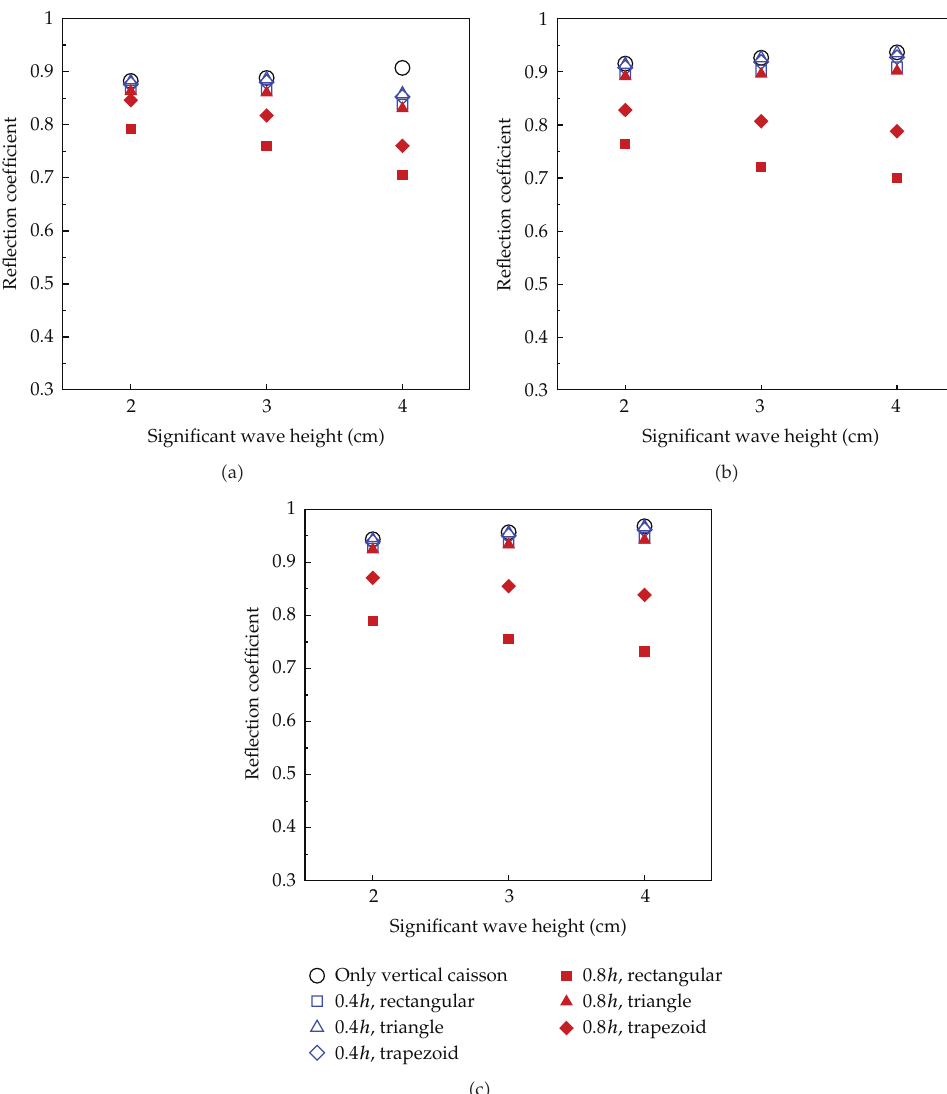
Figure 3: Reflection coe ffi cient for vertical caisson with di ff erent significant wave